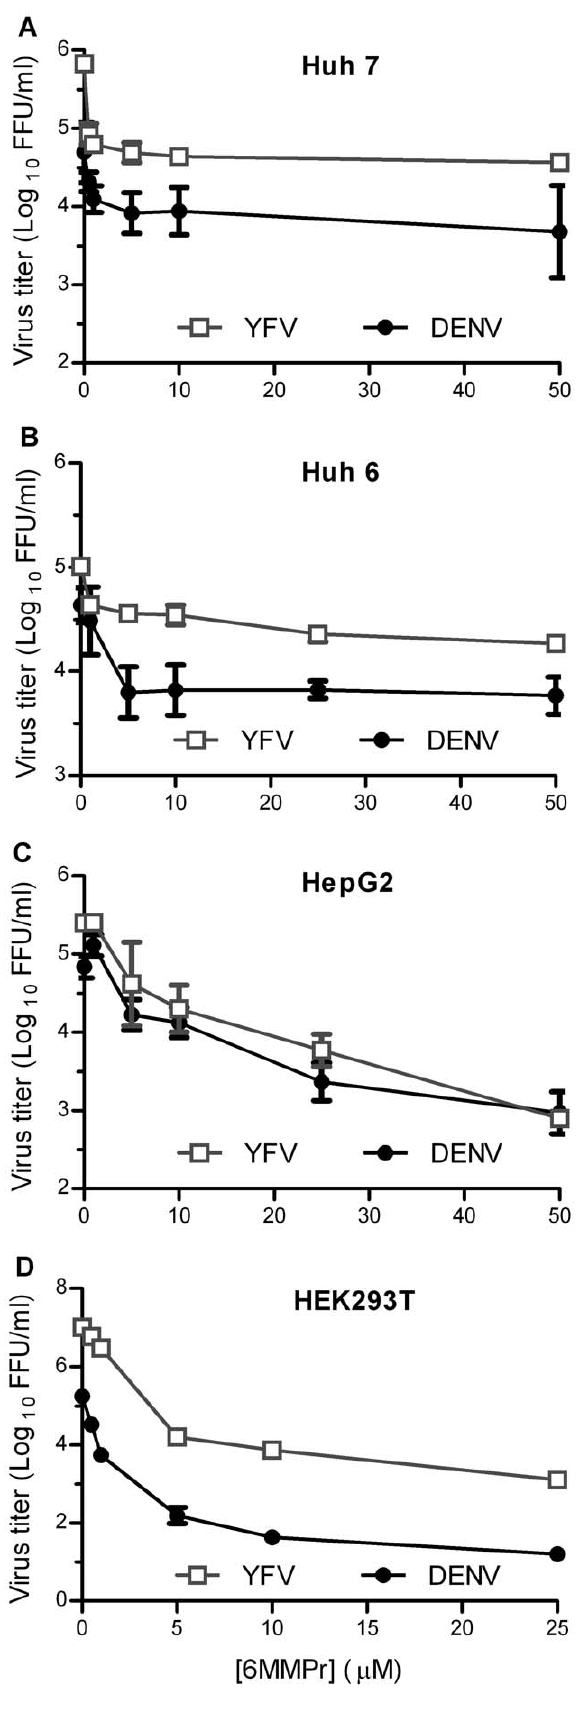
Figure 1. 6MMPr inhibited DENV and YFV production in multiple cell lines in a dose-dependent manner. (A) Huh7, (B) Huh6, (C) HepG2, and (D) HEK293T cells were inoculated with DENV-2 (16681) or YFV in the presence of various concentrations of 6MMPr. Medium was harvested at 48 hpi, and viral titers were determined by fluorescent focus assays. At least two independent experiments were performed, and the means 6 standard deviations from one experiment, performed in triplicate, are